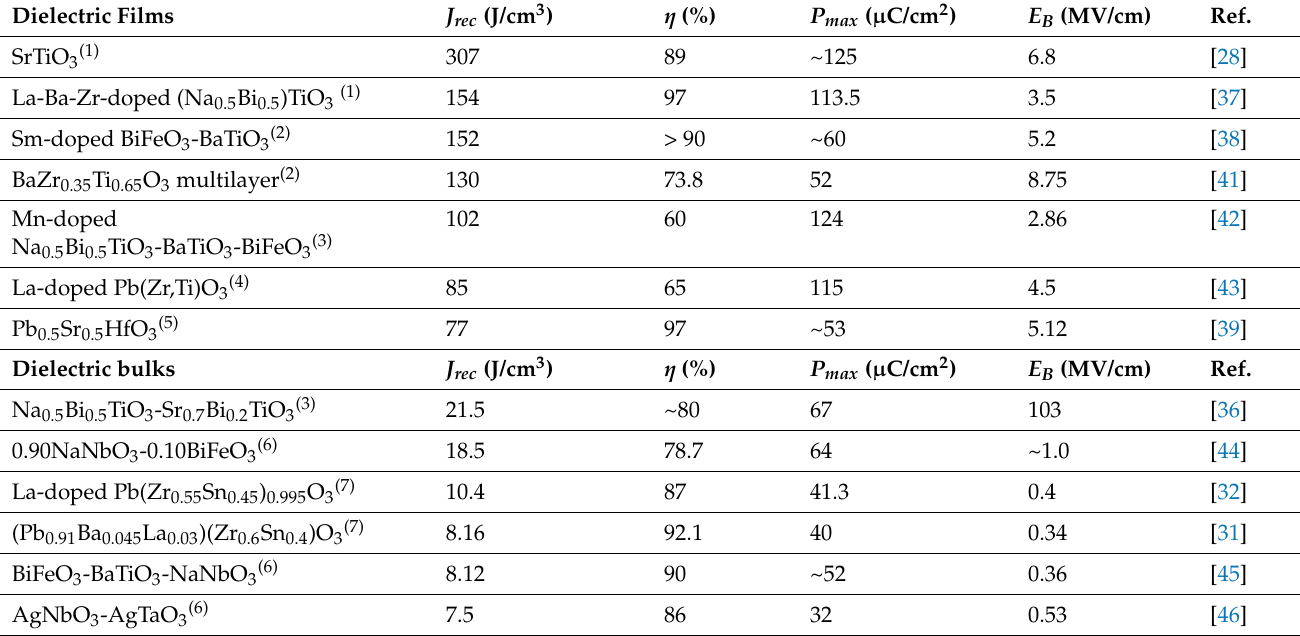
Table 1. Comparison of energy storage performance between representative dielectric films and between representative dielectric